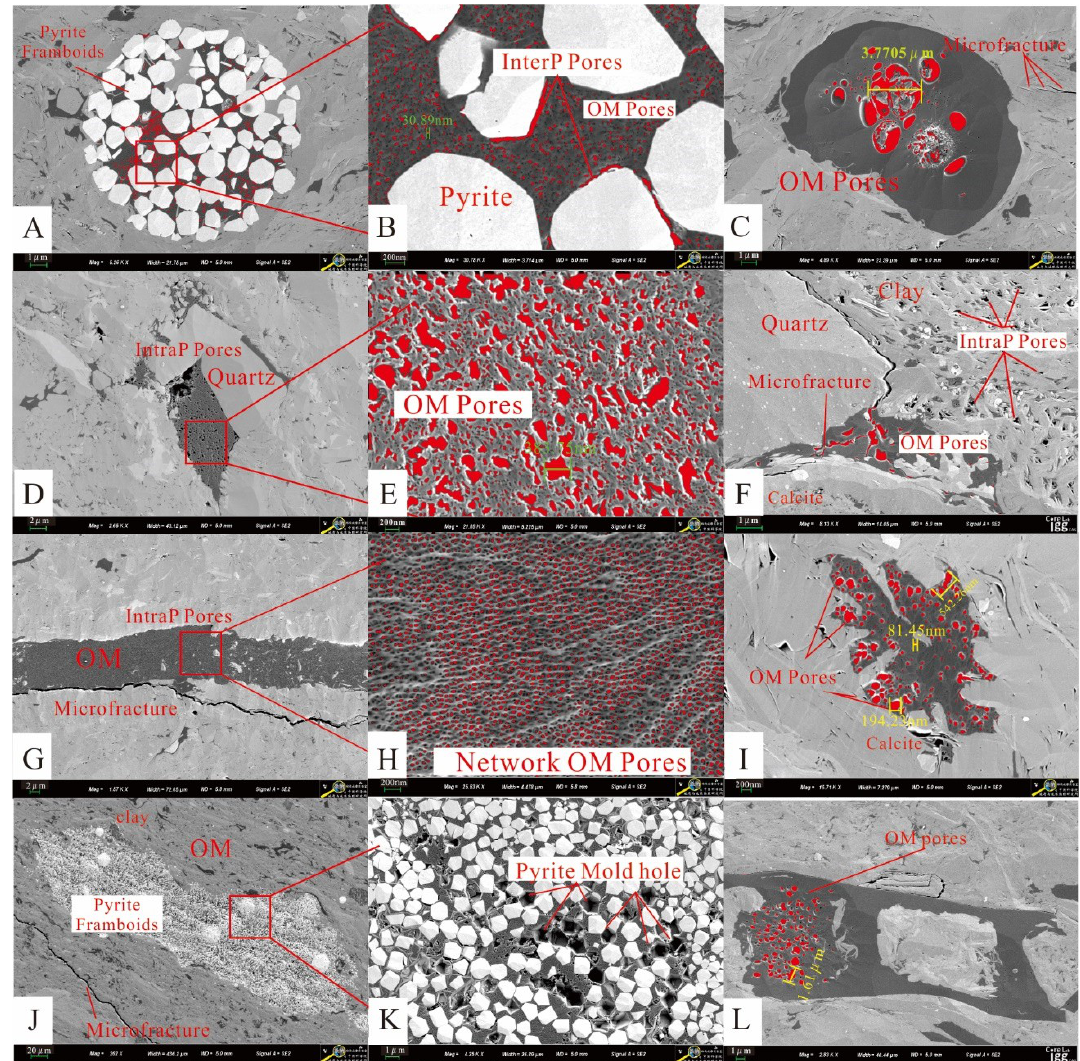
Figure 4. FE-SEM images of OM pores in the Shahezi shales in CFD. ( A ) OM filled in pyrite framboids grains contain small oval OM pores with pore diameters of about 30 nm. ( B ) enlarged square area from image A. ( C ) Heterogeneous characteristics of organic matter (OM) pores. ( D , E ) Sponge-like OM pores hosted in OM coexist with quartz. ( F ) cracks around quartz grains and pores in OM-clay composites. ( G , H ) Complex OM pore networks with small width. ( I ) Heterogeneous OM pore characteristics in the same OM particle with wide pore size. ( J , K ) mold holes and OM pores associated with pyrite framboids. ( L ) Different pore characteristics in same samples.